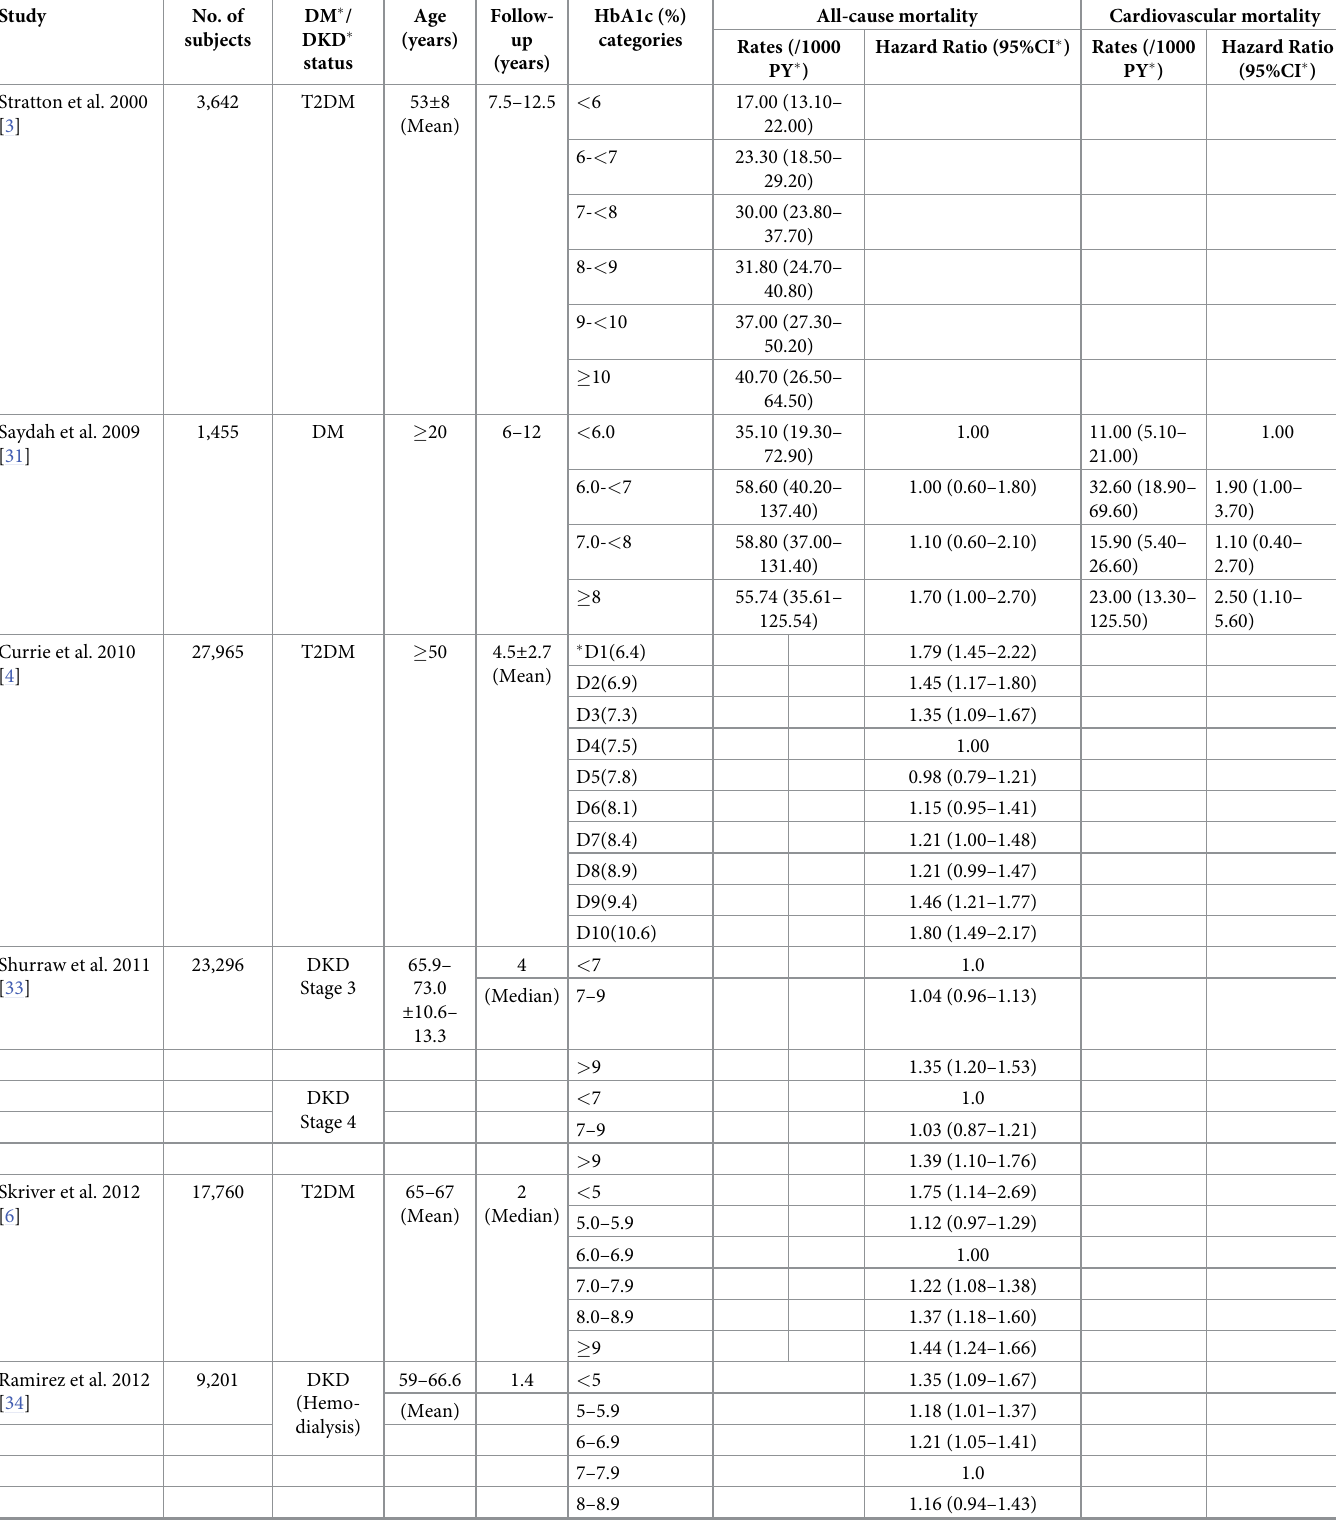
Table 2. Literature association between HbA1c and all-cause and cardiovascular mortality.